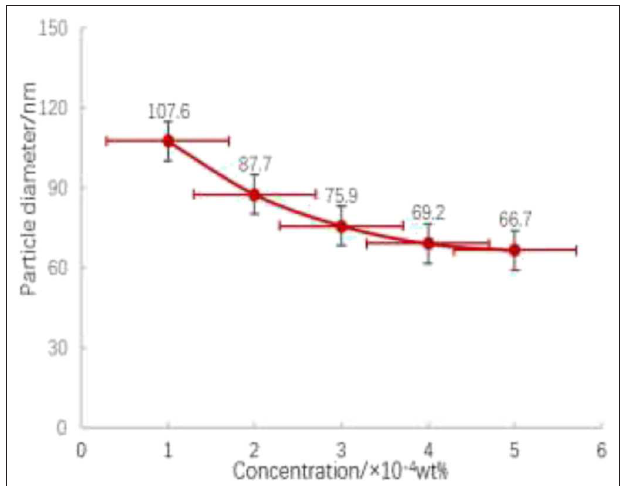
FIGURE 12 | Gradient diagram of Janus nanoparticle size with CTAB